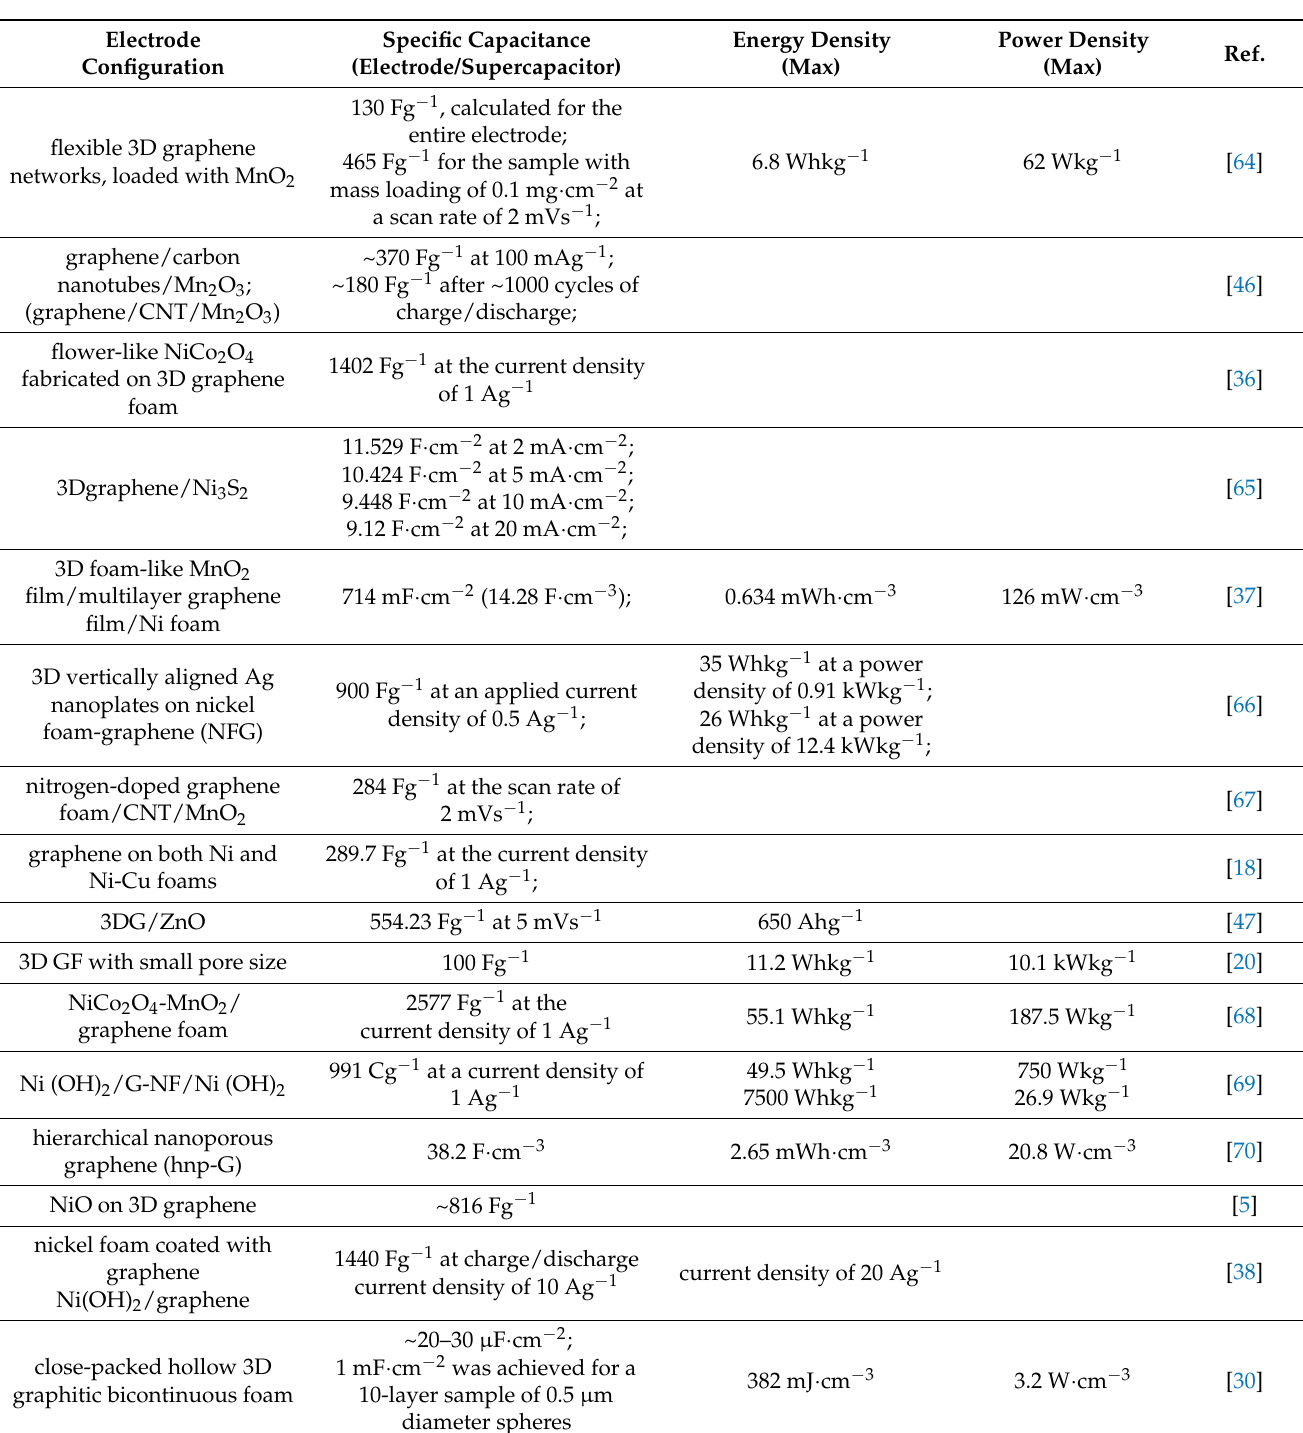
Table 3. Summary of the main performance features of several electrode/supercapacitor configura- tions using 3D graphene-based